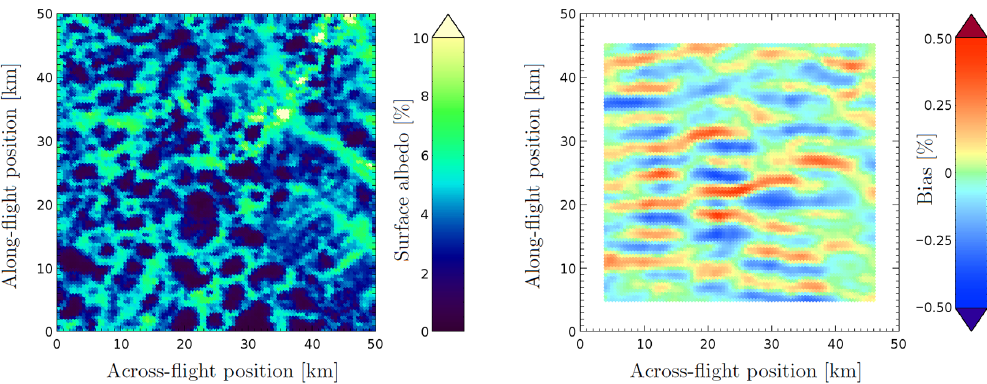
Figure 8. Methane bias due to heterogenous slit illumination for spatially varying surface reflection over a marsh scene at Siberia close to the river Ob at latitude 62.8 ◦ N and longitude 72.1 ◦ E. Measurement simulations are performed with the instrument model by Landgraf et al. (2016) for an instantaneous field of view of 3.4km across the slit and 7.0km along the